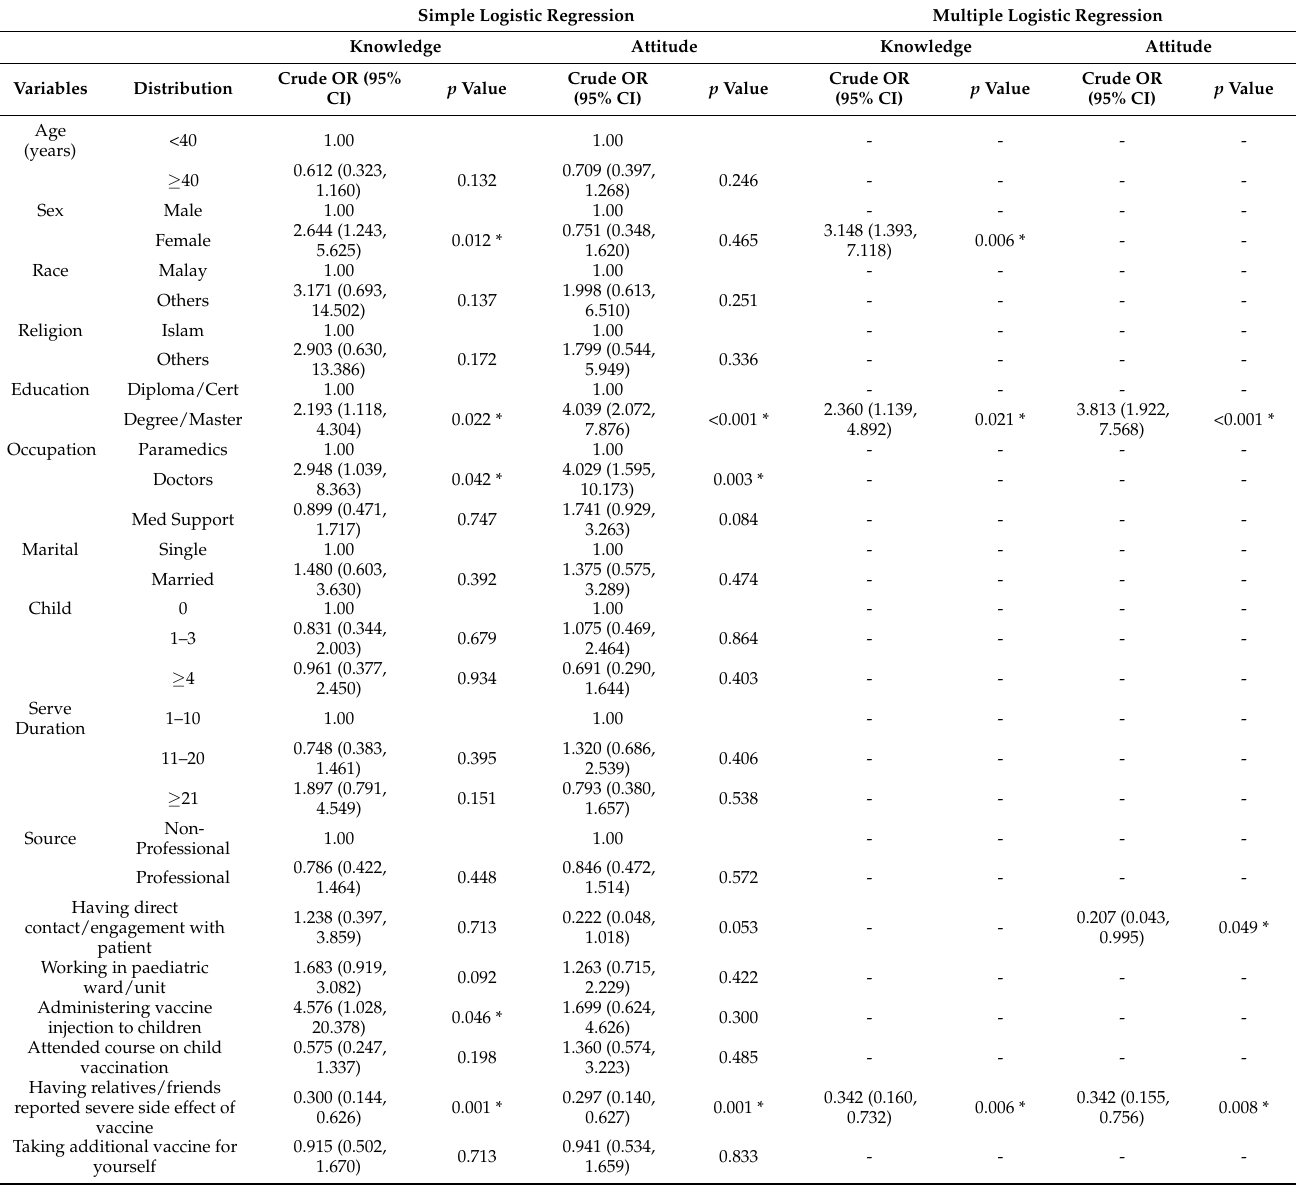
Table 3. Association of variables with knowledge and attitude on childhood